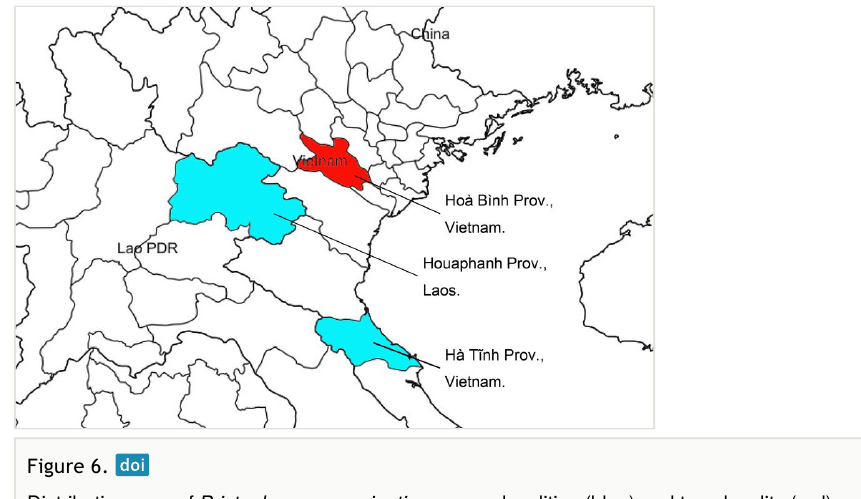
Distribution map of Pristaulacus emarginaticeps , new localities (blue) and type locality